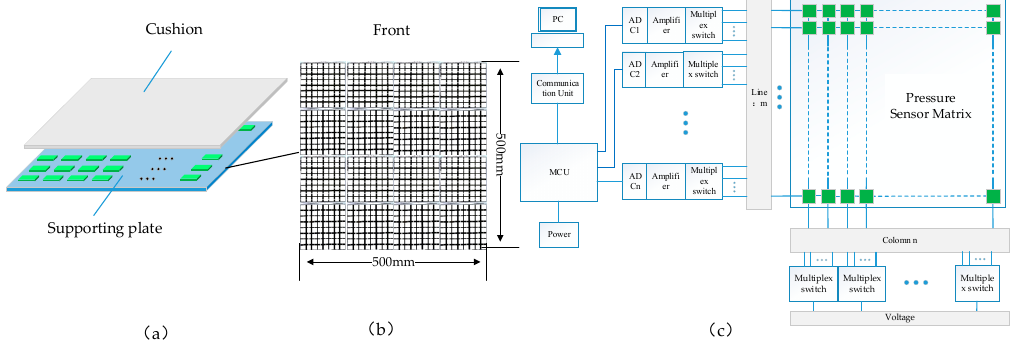
Figure 3. Standing-posture classification system (SPCS) framework: ( a ) structure of the pressure floor; ( b ) sensor matrix; ( c ) data acquisition system.